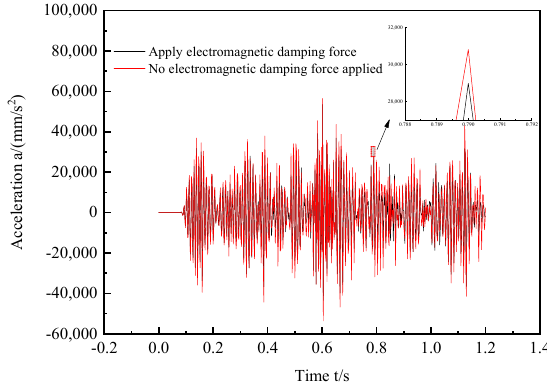
Figure 20. Acceleration comparison.